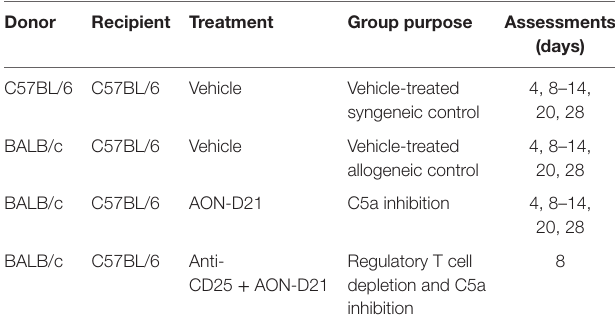
TaBle 1 | Experimental